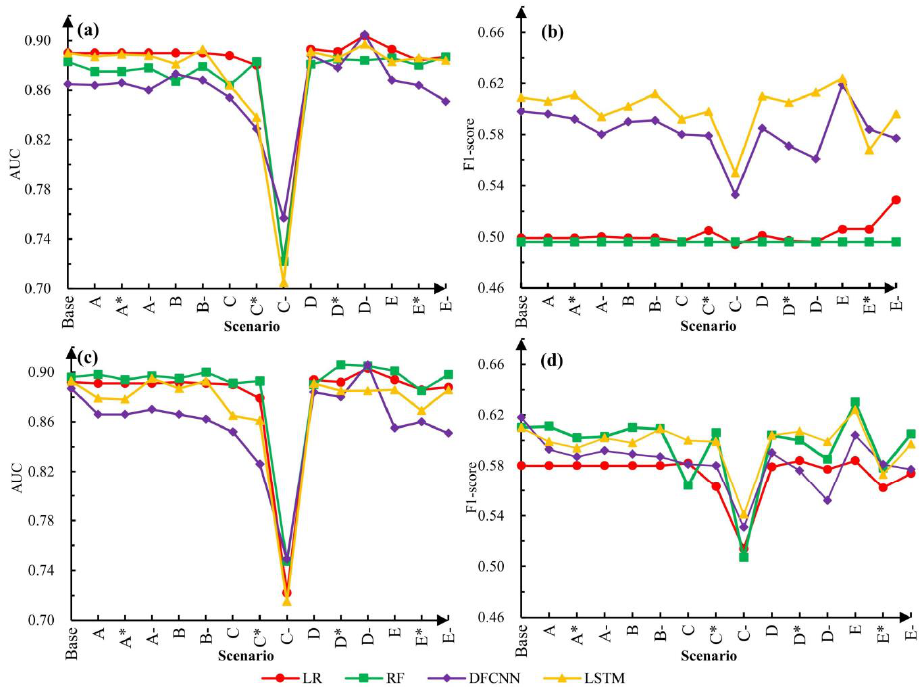
Figure 10. Performances of removing landslide influence factors: ( a ) AUC under class imbalanced strategy, ( b ) F1-score under class imbalanced strategy, ( c ) AUC under class balanced strategy, ( d ) F1-score under class balanced strategy.